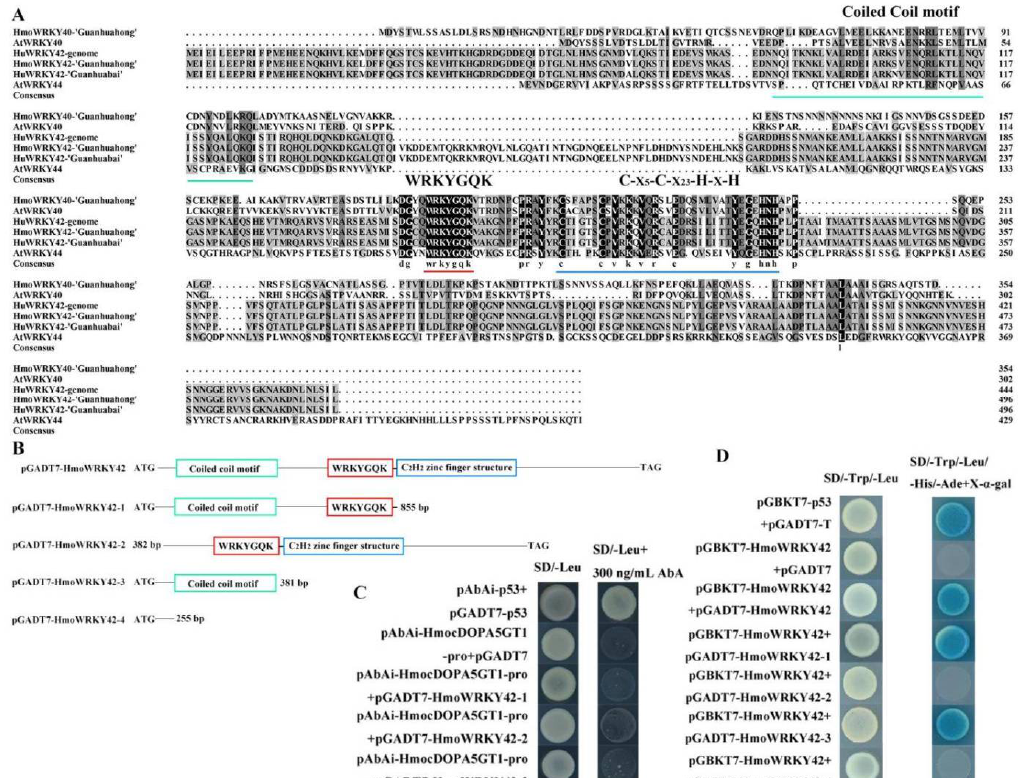
Figure 9. HmoWRKY42 could bind a coiled coil motif and interact with itself to form homodimers. ( A ) The alignment analyses of HmoWRKY42. Coiled coil motif, WRKY domains, and zinc-finger structures are labeled in green, red, and blue underlines, respectively. ( B ) Diagrams of the pGADT7-HmoWRKY42-1, pGADT7-HmoWRKY42-2, pGADT7-HmoWRKY42-3, and pGADT7-HmoWRKY42-4 sequences. ( C ) Yeast one-hybrid assays between the HmocDOPA5GT1 promoter and the motif of HmoWRKY42. ( D ) Yeast two-hybrid assays between HmoWRKY42 and itself.